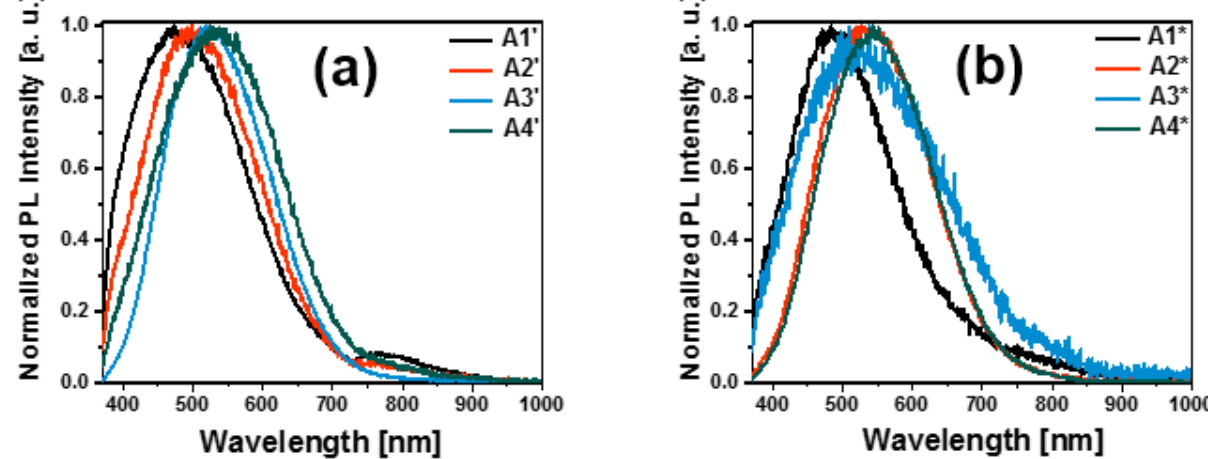
Figure 8. ( a ) The normalized PL spectra of the Si-n/PSi/CNTs/SRO structure, ( b ) normalized PL spectra of the Si-n/PSi/GO/SRO structure.